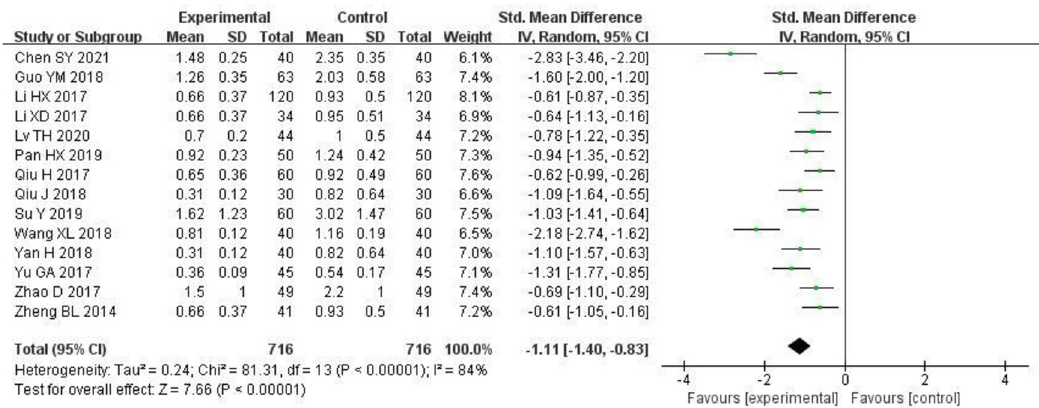
Fig 4. Forest plot of effects of Shenyankangfu tablets and Losartan potassium in the treatment of chronic glomerulonephritis on 24-hour urine protein quantification.